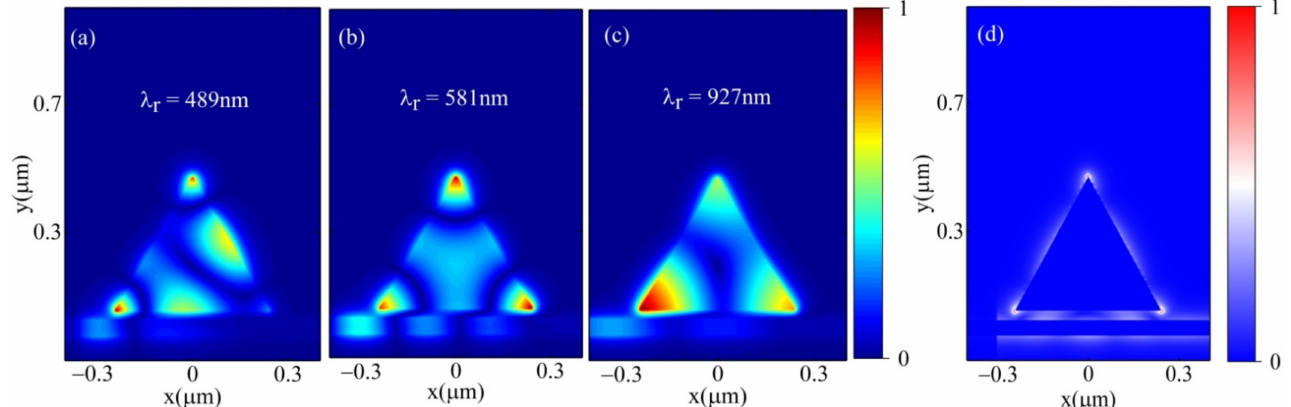
Figure 2. The magnetic distribution profile of the ETSC at: ( a ) λ r = 489 nm; ( b ) λ r = 581 nm; ( c ) λ r = 927 nm; ( d ) the vectorial charge distribution of the ETSC at λ r = 489 nm.